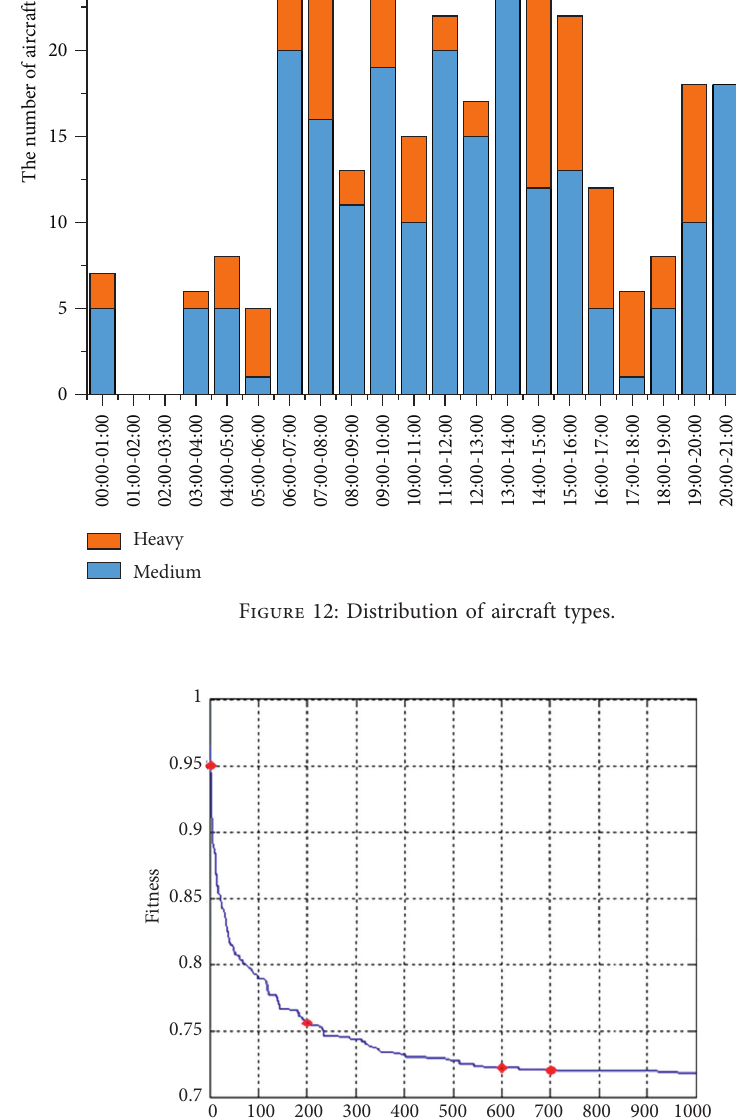
Figure 13: Genetic Algorithm (GA) training